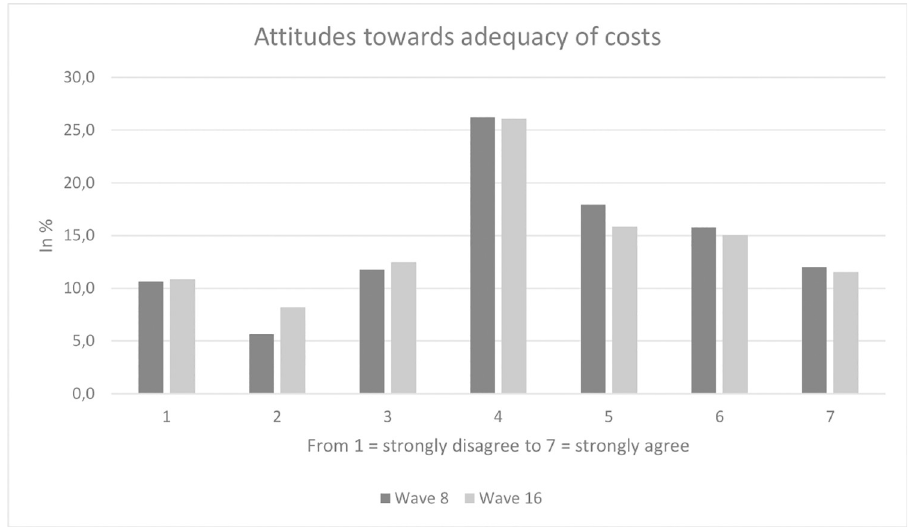
Fig 1. Attitudes towards reasonableness of costs.